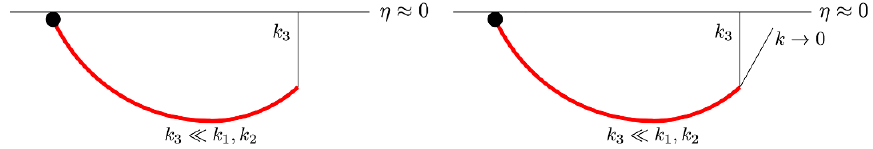
Figure 4 . From left to right: (a) \OPE" approximation of three point function in squeezed limit as a two point function. The (cid:30) 0 background causing mixing is not explicitly shown, as in (cid:12)gure 3. (b) The same \OPE" approximation expressed an in(cid:13)aton- h three point function with one in(cid:13)aton leg set to zero momentum to now explicitly represent the background (cid:30) 0